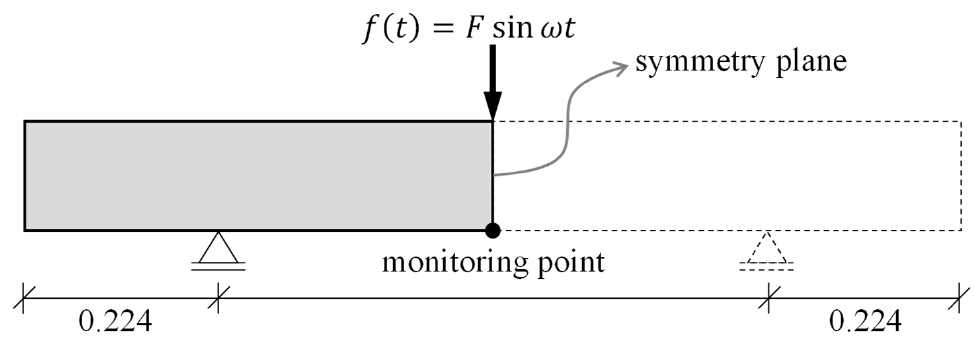
Figure 14. The boundary conditions of the numerical model and the applied load. A harmonic point load with an amplitude of 1 N was applied at the mid-span of the beam. The frequency range of the load was within 500 to 1500 Hz. For the response curve of the model, the deformation at the mid-span was considered as the monitoring point (Figure 14).